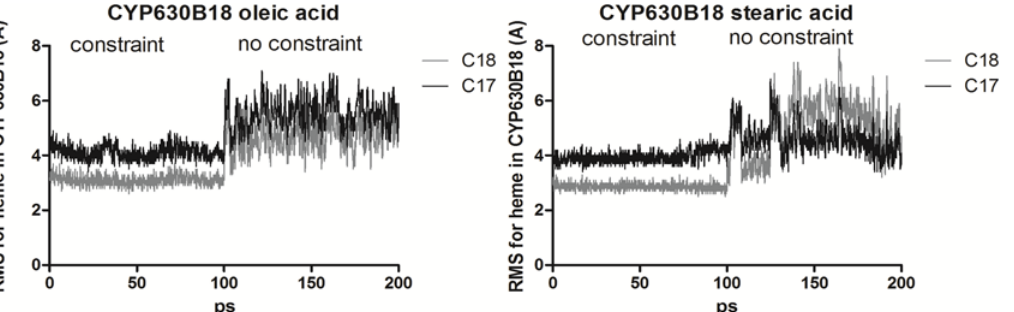
Fig 7. Time course of the root mean square (RMS) changes of the heme moiety in Gs CYP630B18 with oleic acid (left) and stearic acid (right) as a substrate. The protein was constrained for the first 100 ps.